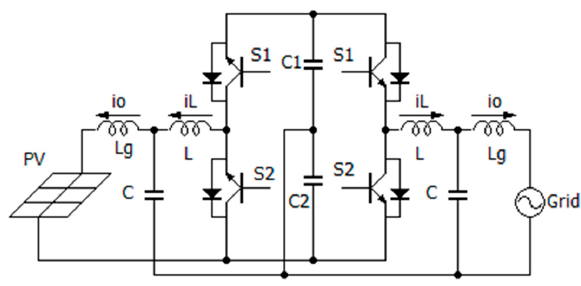
Figure 8. Grid-connected PV panel circuit.